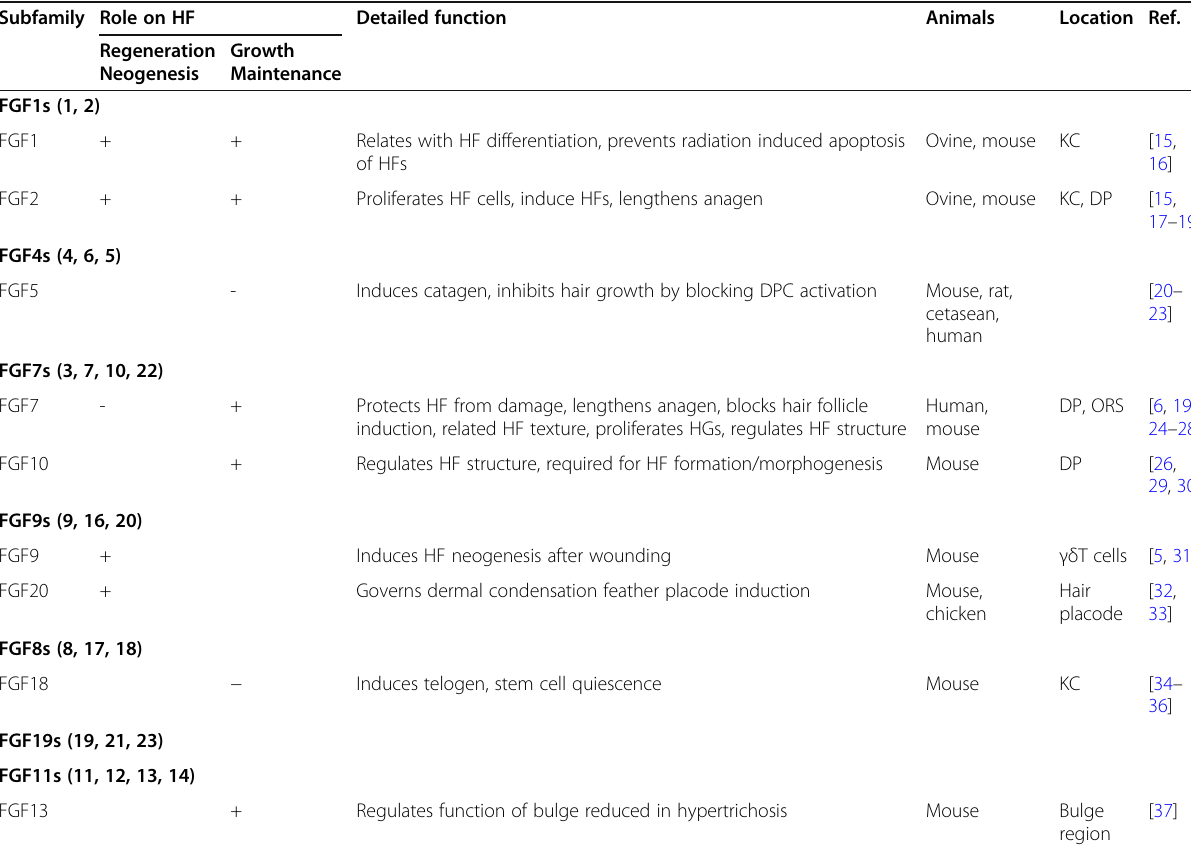
Table 1 Summary of the role of fibroblast growth factors (FGFs) which influence on regeneration/neogenesis and growth/ maintenance of hair follicle